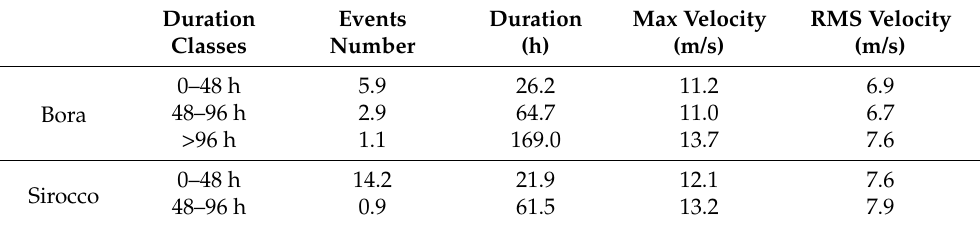
Table 1. Summary of selected events recorded at the Grado anemometer, grouped according to direction and event duration. For each class, the average annual number of events and their duration are specified, together with the average annual value of maximum and root-mean square (RMS) event